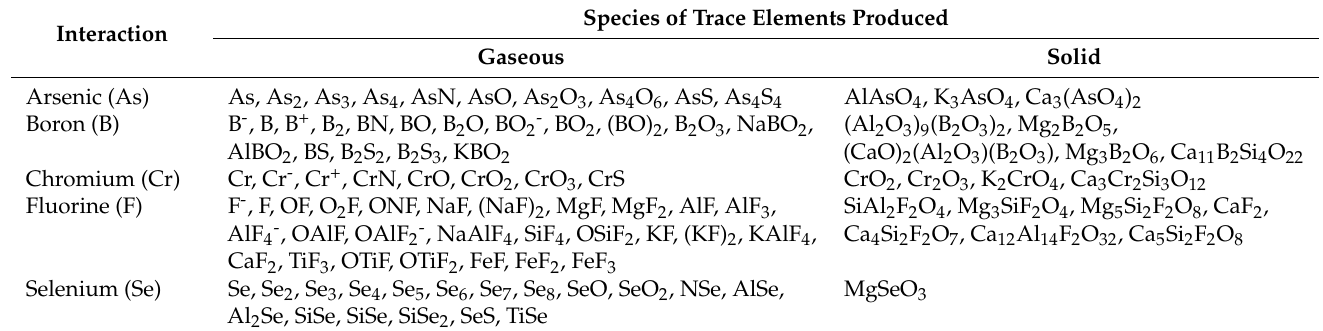
Table 4. Prediction of the species during the interaction of trace elements with CFA during the combustion process. Species of Trace Elements Produced Interaction Gaseous